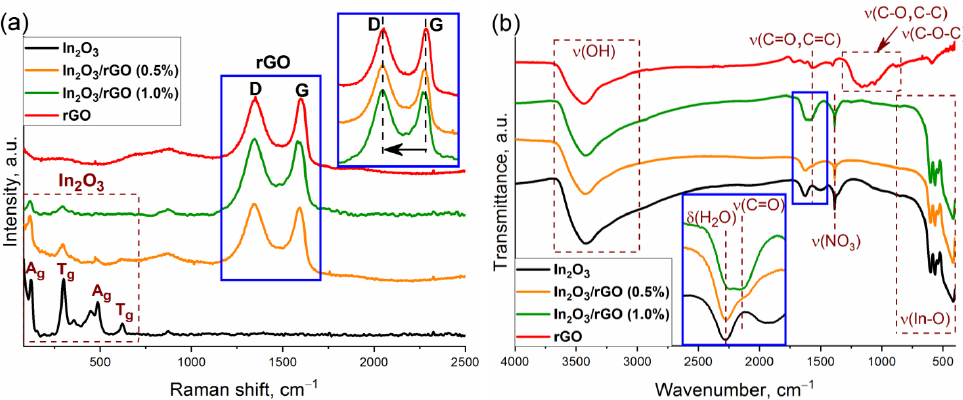
Figure 3. Raman spectra ( a ) and FTIR spectra ( b ) of the In 2 O 3 , rGO, and In 2 O 3 /rGO composites.